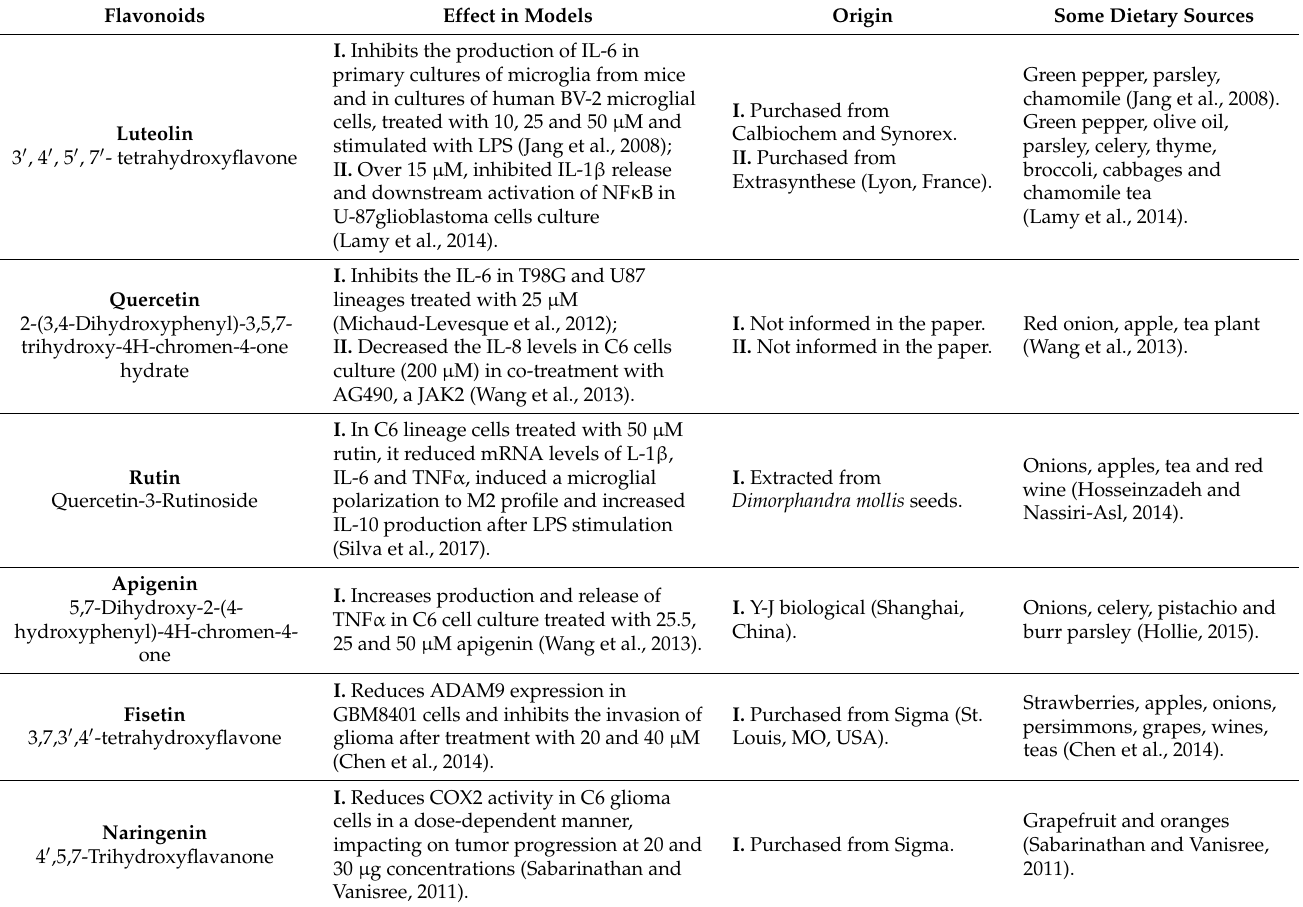
Table 2. Some flavonoids that act in different signaling pathways in glioma cells. Flavonoids Effect in